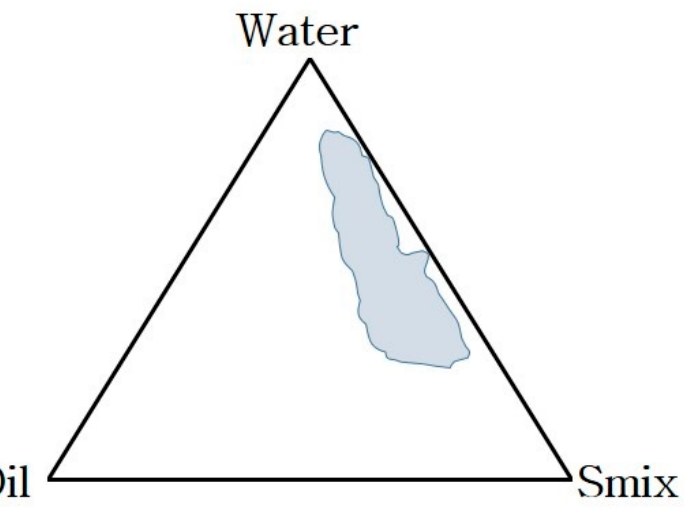
Figure 2. Pseudoternary phase diagram at Smix ratio 2:1 exhibiting maximum nanoemulsification region having a composition of oil phase as capryol 90 and Smix phase consist of tween 20 and PEG 200.